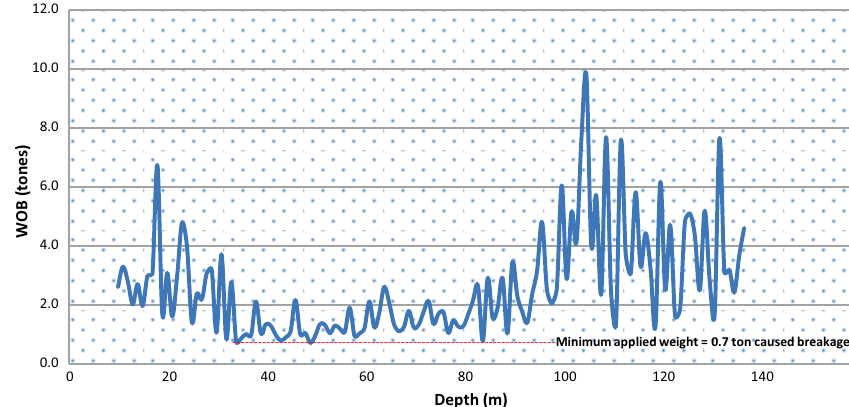
Fig. 6 Weight on bit versus depth for the first cluster (Pila Spi) formation